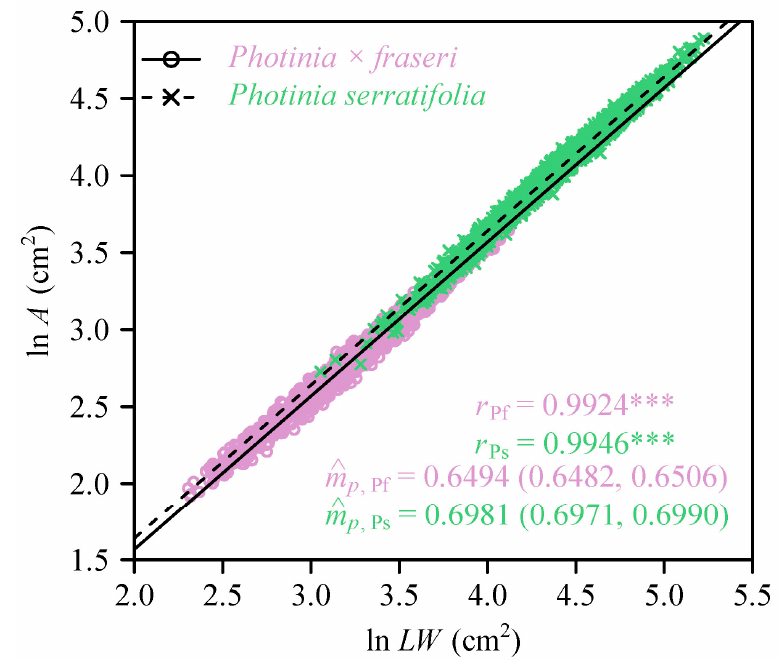
Figure 2. Log-log bivariate plot of leaf area ( A ) vs. the product leaf length ( L ) and width ( W ). The symbol ˆ m p represents the estimated value of the Montgomery parameter, i.e., the estimated proportionality coefficient of the Montgomery equation. The subscripts Pf and Ps represent the hybrid P. × fraseri , and one of its parents P. serratifolia , respectively. *** denotes p < 0.001 for a correlation coefficient.